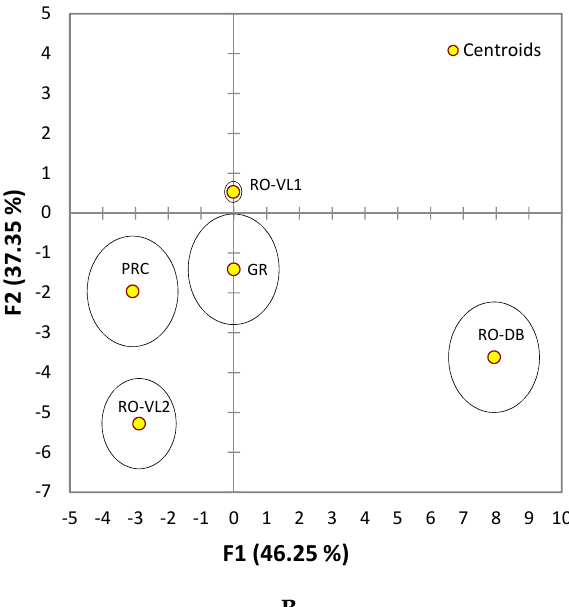
Figure 1. Discriminant analysis of walnuts according to the geographical origin of the walnut samples: ( A ) samples distribution by groups; ( B ) group centroids as mean discriminant scores for each group in the dependent variable for each of the discriminant functions.